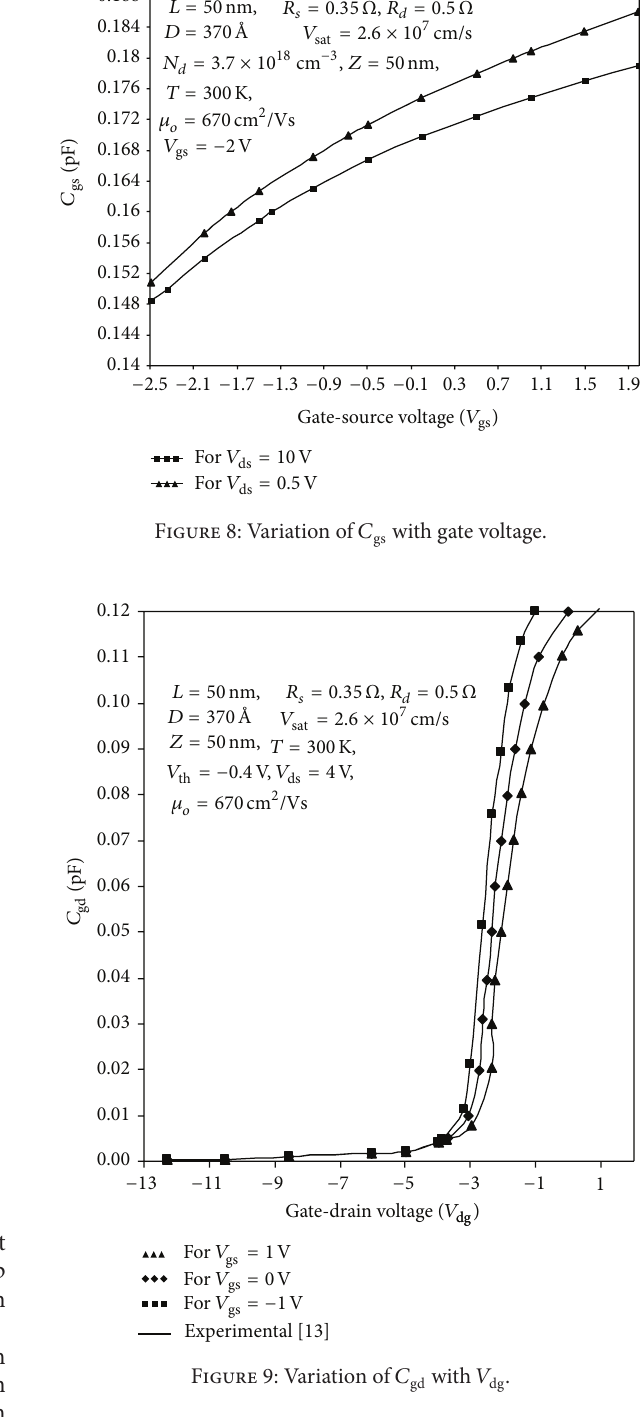
high at low drain currents due to decrease in gate to source capacitance. It increases for shorter gate lengths. The drain noise coefficient 𝑃 decreases with lower values of drain currents. It also decreases for shorter gate lengths. The calculated/obtained results are in close proximity with the previously published results